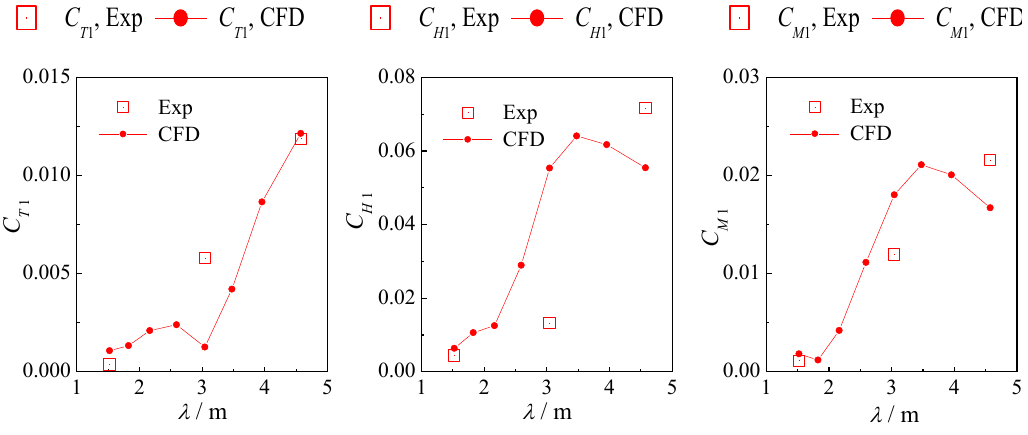
Figure 7. Numerical verification of hull force and moment coefficients at different wavelengths (the red box ( ) is the test result of the literature and the red dot ( . ) is the CFD calculation result of this paper).